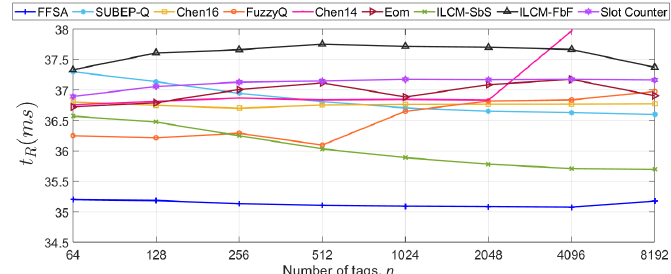
Figure 5. Evaluation results of the average time to read one sensor data from one tag in one frame in S1.